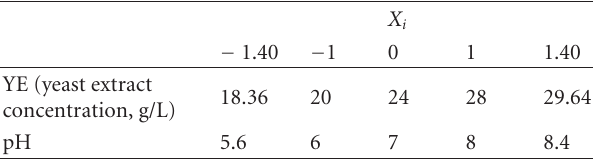
Table 3: Coded and actual values of variables in the second central composite